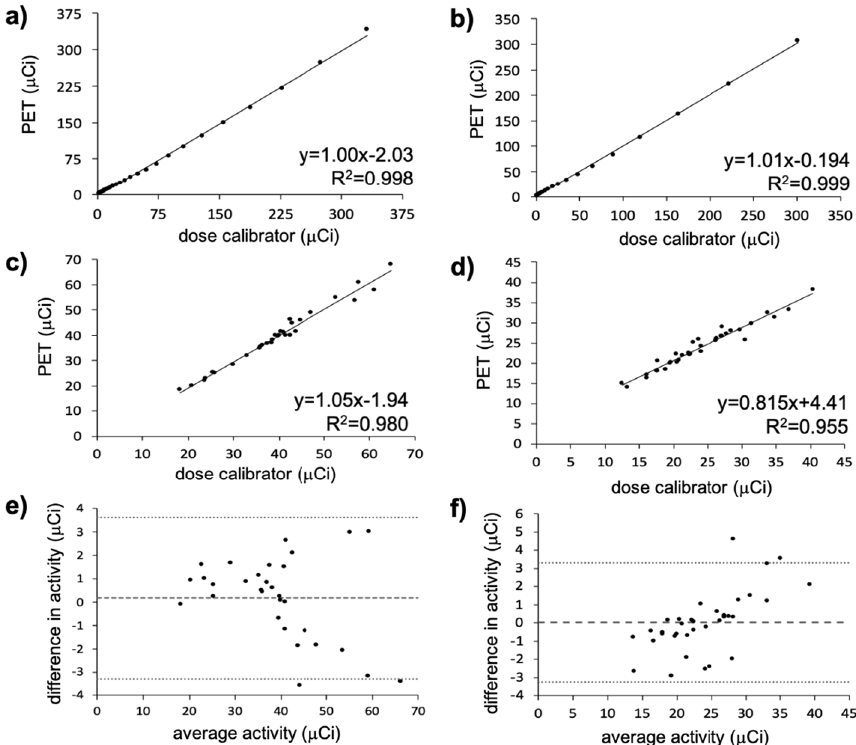
Fig. 1 PET radioactivity quantification in the presence of the MRI instrument. Phantoms with ( a ) 12.58 MBq (340 µCi) of fluorine-18 and ( b ) 11.1 MBq (300 µCi) of gallium-68, were each placed in the axial center of the PET insert. The insert was loaded into the MRI instrument, and a simultaneous PET/MRI scan was recorded every 30 min over a 12 h time period. Each data point represents the amount of activity extrapolated from an initial measurement with a dose calibrator or measured from the PET image for each 30 min time point. The black line represents a linear fit of the data. Phantoms with ( c ) 0.37–2.59 MBq (10–70 µCi) of fluorine-18 or ( d ) 0.37–1.67 MBq (10–45 µCi) of gallium-68 were placed in the axial center of the PET insert. The insert was loaded into the MRI instrument, and each tube was scanned for 30 min using simultaneous PET/MRI. The black line represents a linear fit of the data. ( e ) A Bland–Altman analysis was performed for the data in Fig. 1c. The bias was 0.173 (dashed line), which was not significantly different than 0 ( p 0.432). The 95% limits of = agreement were 3.47 (dotted lines). Linear regression analysis produced a slope of 0.054, which was ± − significantly different than 0 ( p 0.024). ( f ) A Bland–Altman analysis was performed for the data in Fig. 1d. = The bias was 0.030 (dashed line), which was not significantly different than 0 ( p 0.489). The 95% limits = of agreement were 3.30 (dotted lines). Linear regression analysis produced a slope of 0.183, which was ± significantly different than 0 ( p 1.17 10 –5 = ×